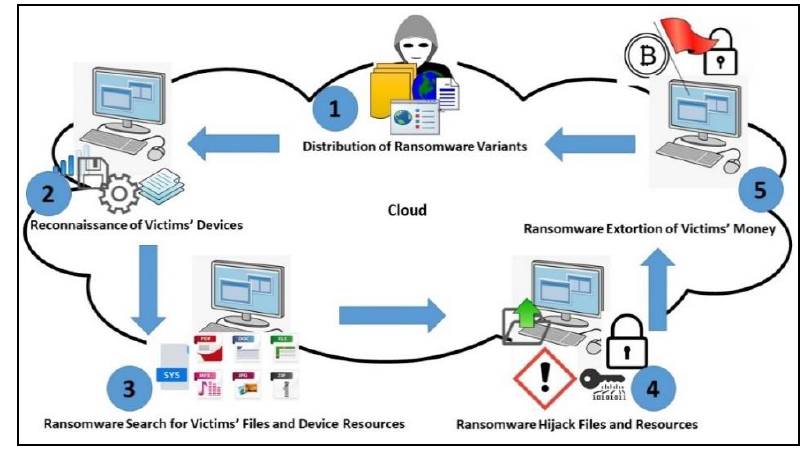
Figure 1. Ransomware routine.